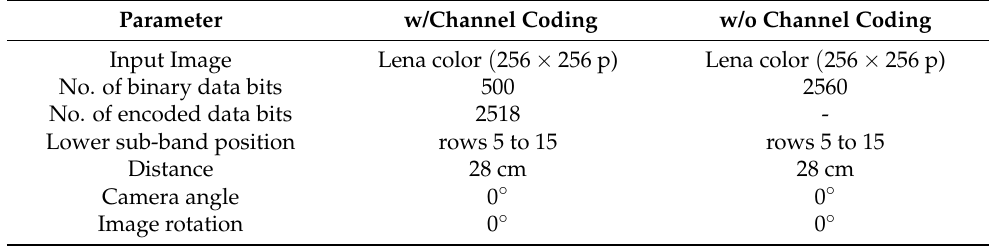
Table 2. Experimental parameters for channel